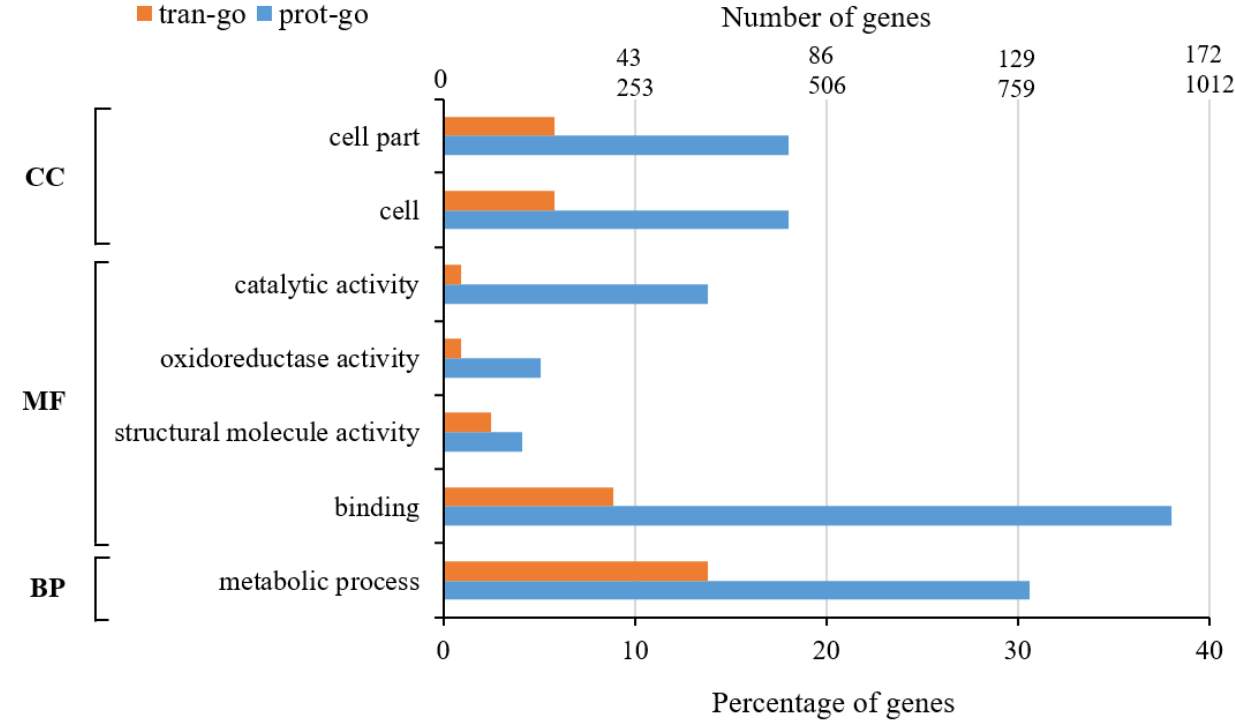
Figure 4. Correlation bar graph of DEGs/DEPs in GO enrichment of transcriptome and proteome. Among them, the results of cells and cell parts were the same, each with 78 DEPs and 148 DEGs, accounting for 18.0% of the total DEPs and 5.8% of the total DEGs. Sixty DEPs were in the catalytic activity group, accounting for the total difference 13.8% of the